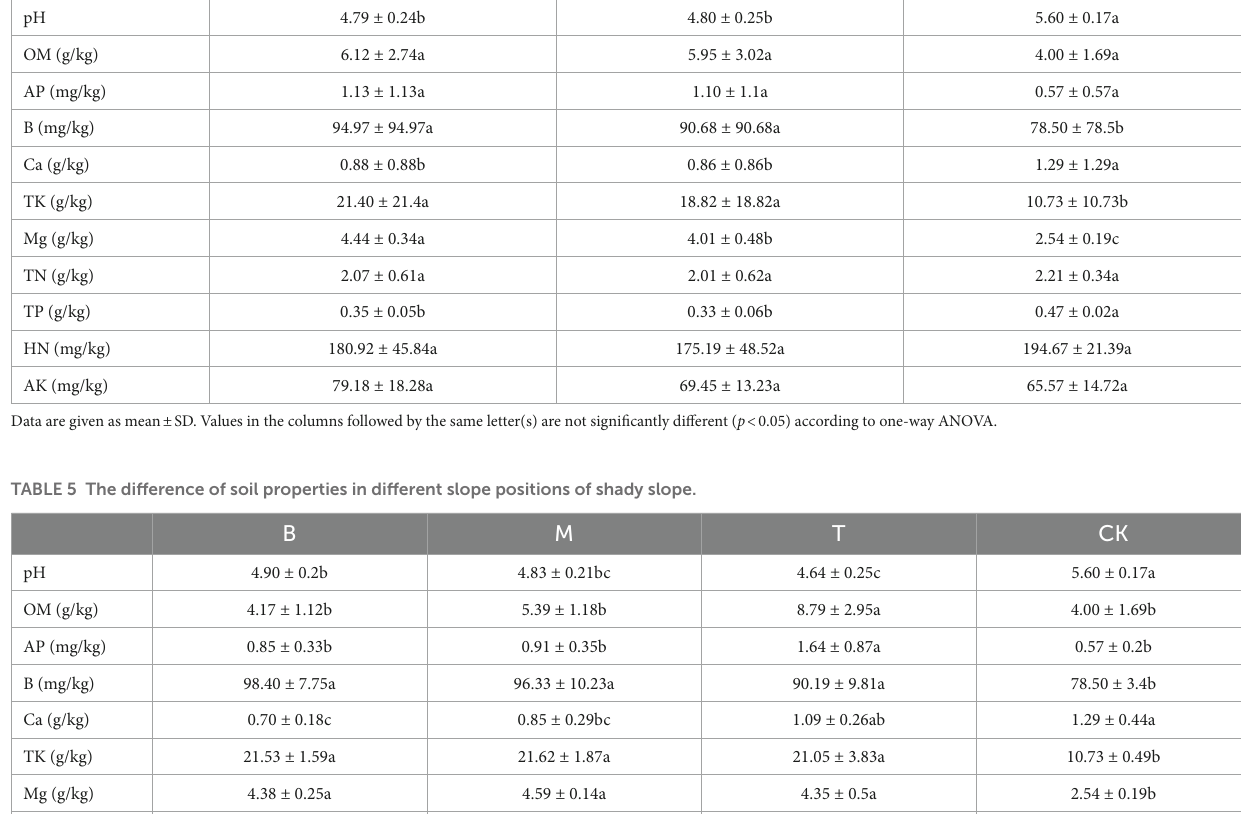
TABLE 4 The difference of soil properties in different slope directions.